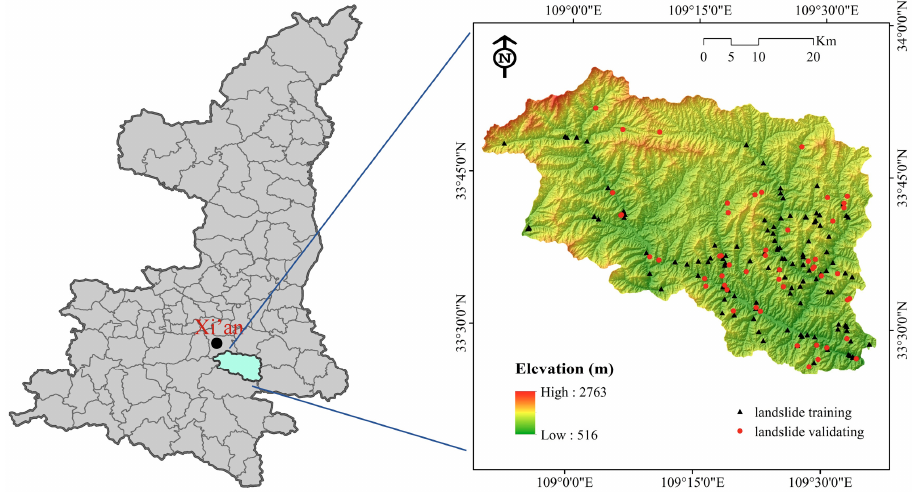
Figure 1. Geographical position of the study area.